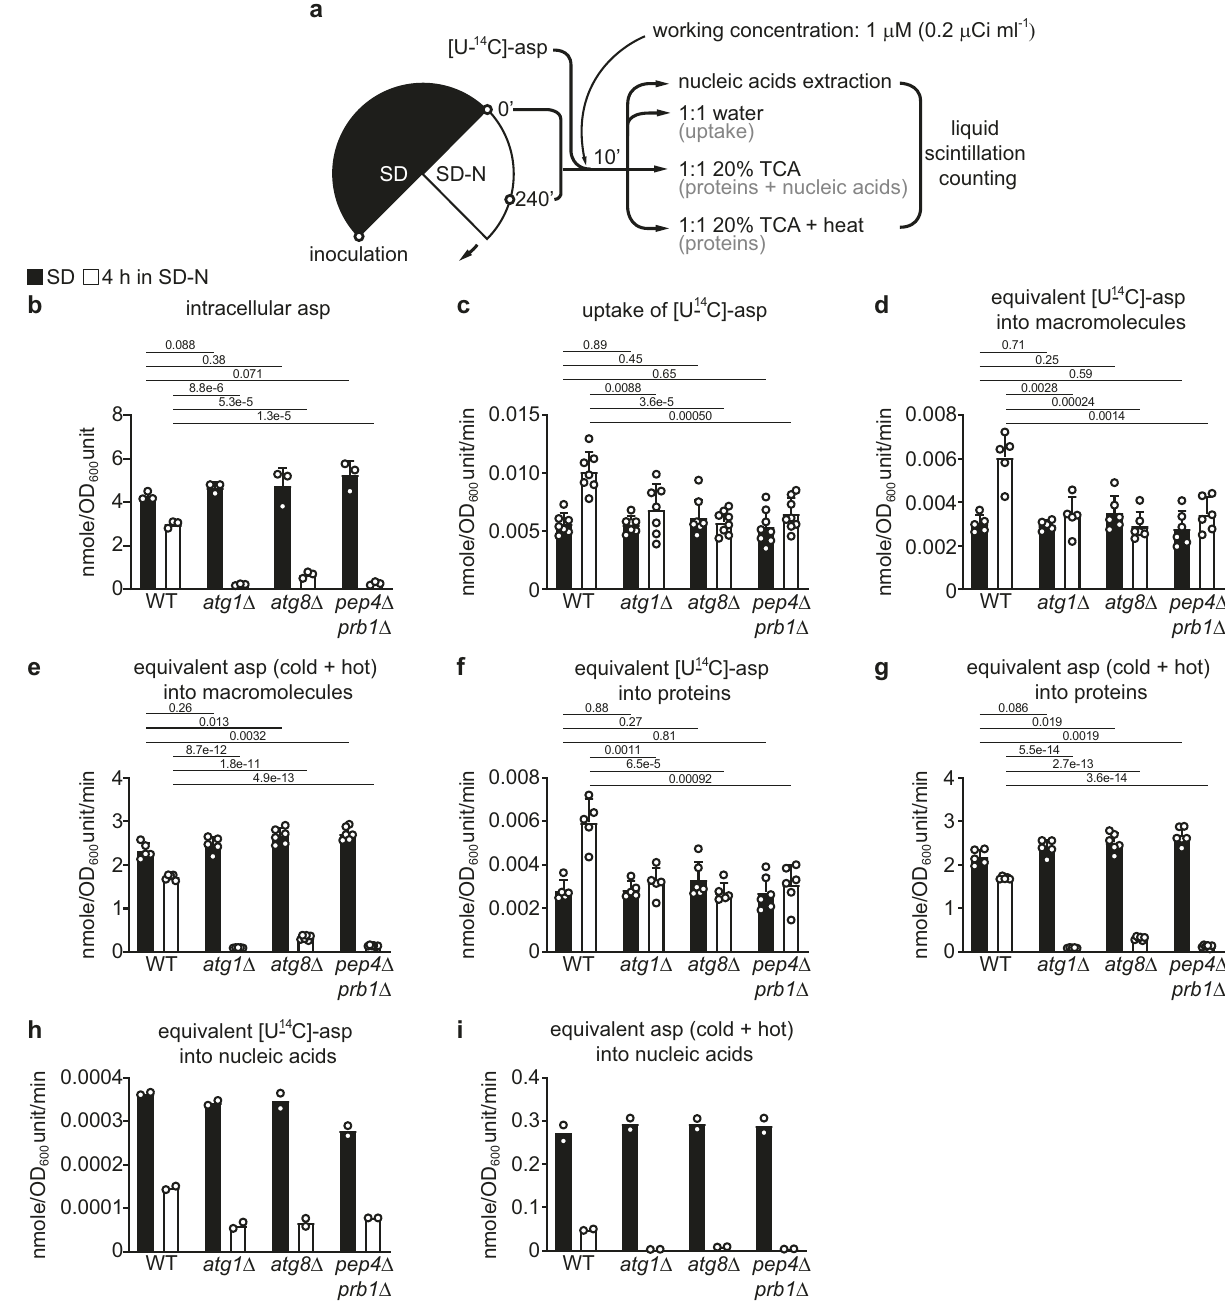
Fig. 8 Other autophagy-de fi cient mutants are also defective in assimilating aspartate into macromolecules under nitrogen starvation. a Schematic of the experimental design. b Estimation of intracellular aspartate concentration. Three independent replicates. c Uptake of [U- 14 C]-aspartate. Seven independent replicates for WT and atg1 Δ , and eight for atg8 Δ and pep4 Δ prb1 Δ . d Incorporation of equivalents of [U- 14 C]-aspartate (aspartate and its derivatives) into macromolecules. Five independent replicates for WT and atg1 Δ , and six for atg8 Δ and pep4 Δ prb1 Δ . e Incorporation of total aspartate equivalents into macromolecules. Five independent replicates for WT and atg1 Δ , and six for atg8 Δ and pep4 Δ prb1 Δ . f Incorporation of equivalents of [U- 14 C]-aspartate into proteins. Five independent replicates for WT and atg1 Δ , and six for atg8 Δ and pep4 Δ prb1 Δ . g Incorporation of total aspartate equivalents into proteins. Five independent replicates for WT and atg1 Δ , and six for atg8 Δ and pep4 Δ prb1 Δ . h Incorporation of equivalents of [U- 14 C]-aspartate into nucleic acids. Two independent replicates. i Incorporation of total aspartate equivalents into nucleic acids. Two independent replicates. P values were calculated using unpaired two-sided Student ’ s t test assuming equal variances. Data are presented as mean ± standard deviation for b – g and mean only for h and i